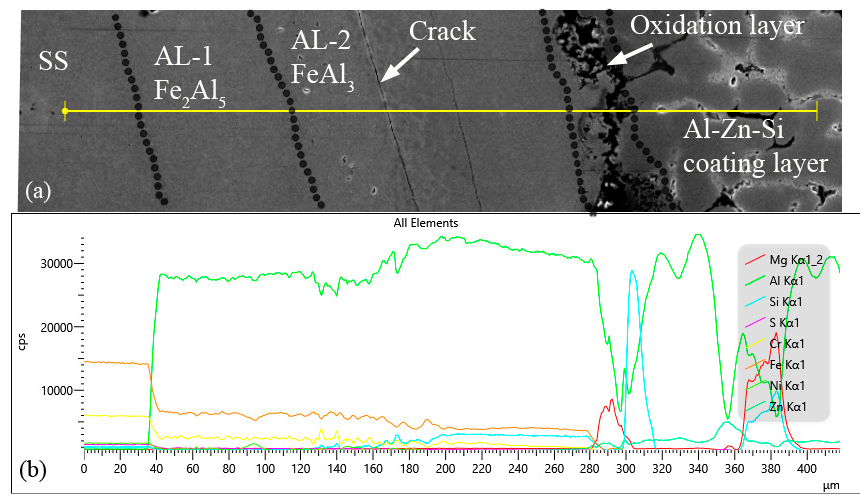
Figure 12. Elemental composition depth profiling from SS to AL-1, AL-2 and to AlZn alloy obtained using EDS technique. ( a ). SEM-SEI images, and ( b ). Elemental compositiona profile.